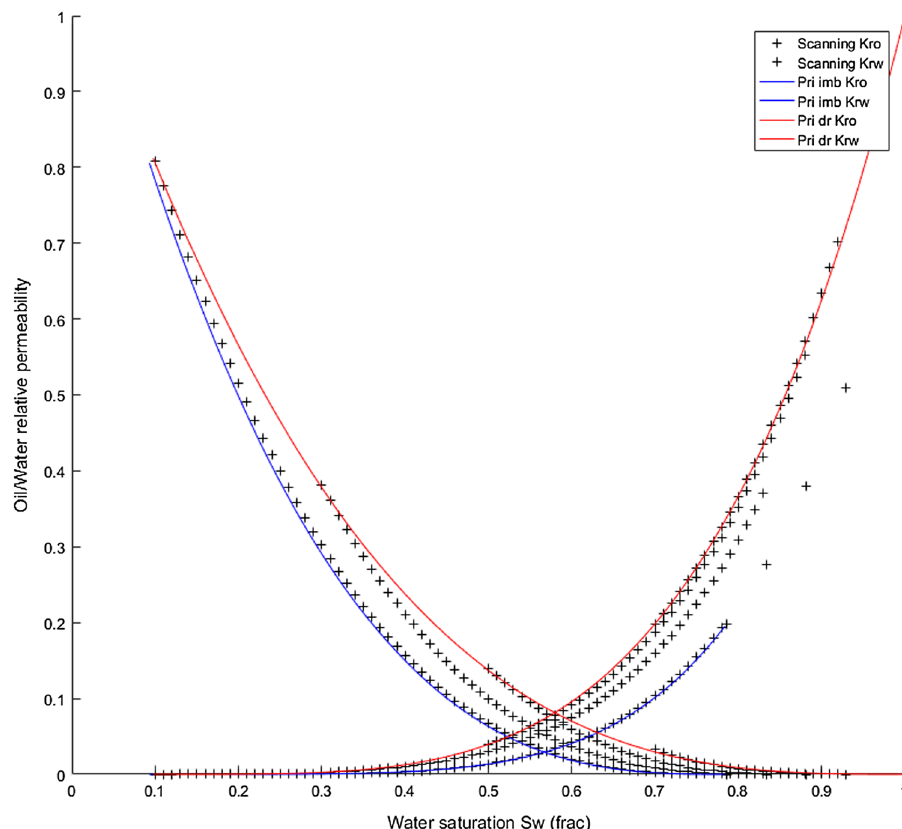
Fig. 16 Bounding drainage/ imbibition curve and scan- ning curve for rock type 4 (Masalmeh model, linear-type